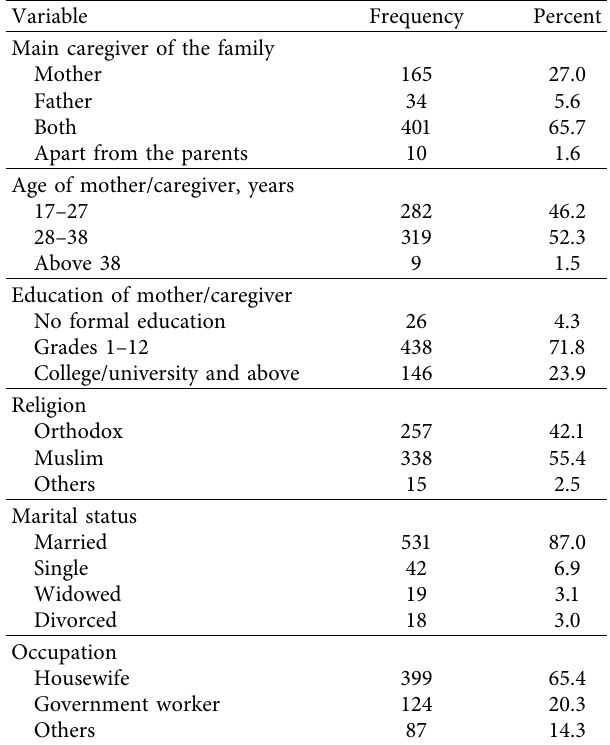
Table 1: Sociodemographic characteristics of mothers in Dessie town, Ethiopia ( N � 610).